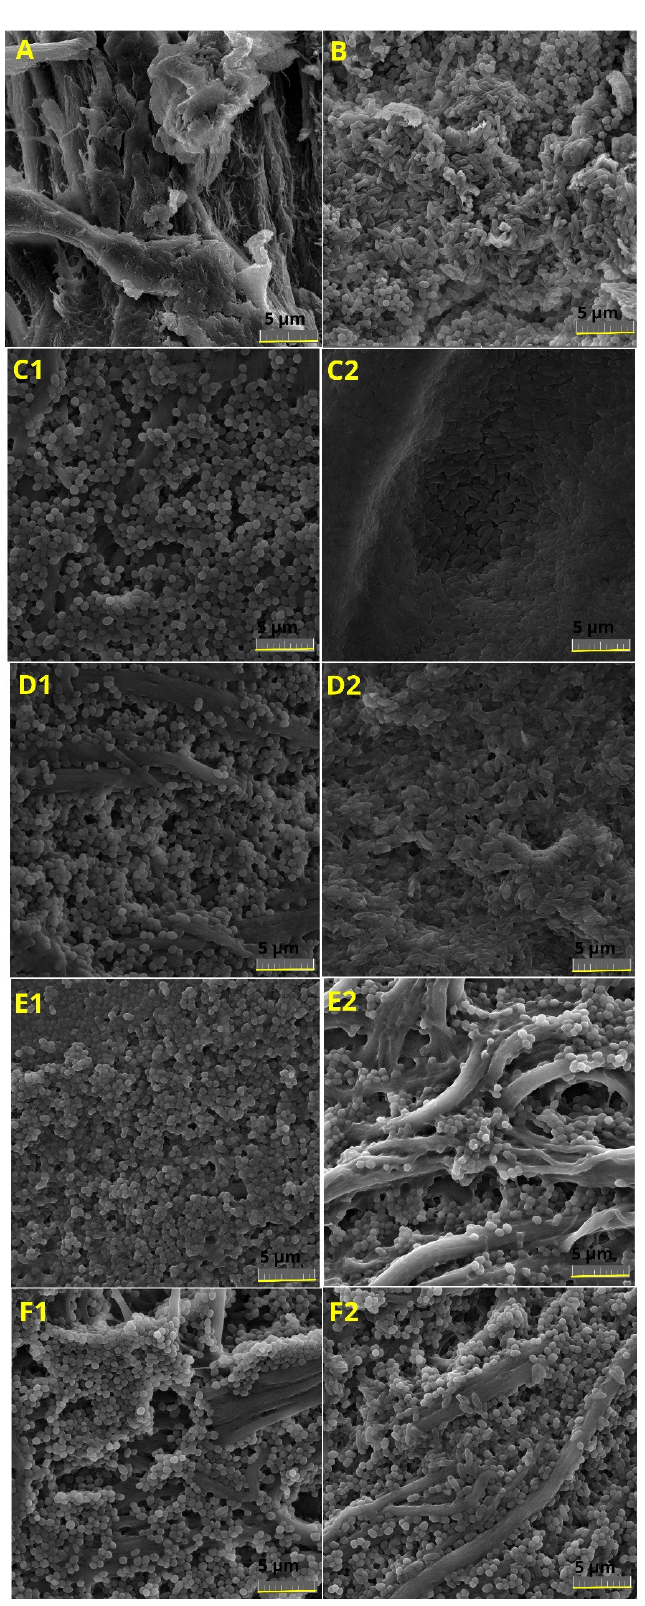
Figure 3. Scanning electron microscopy (SEM) of multispecies biofilms formed by MRSA, P. aeruginosa and E. faecalis non-treated or treated for 1–7 min: ( A ) Collagen membrane without biofilm, ( B )